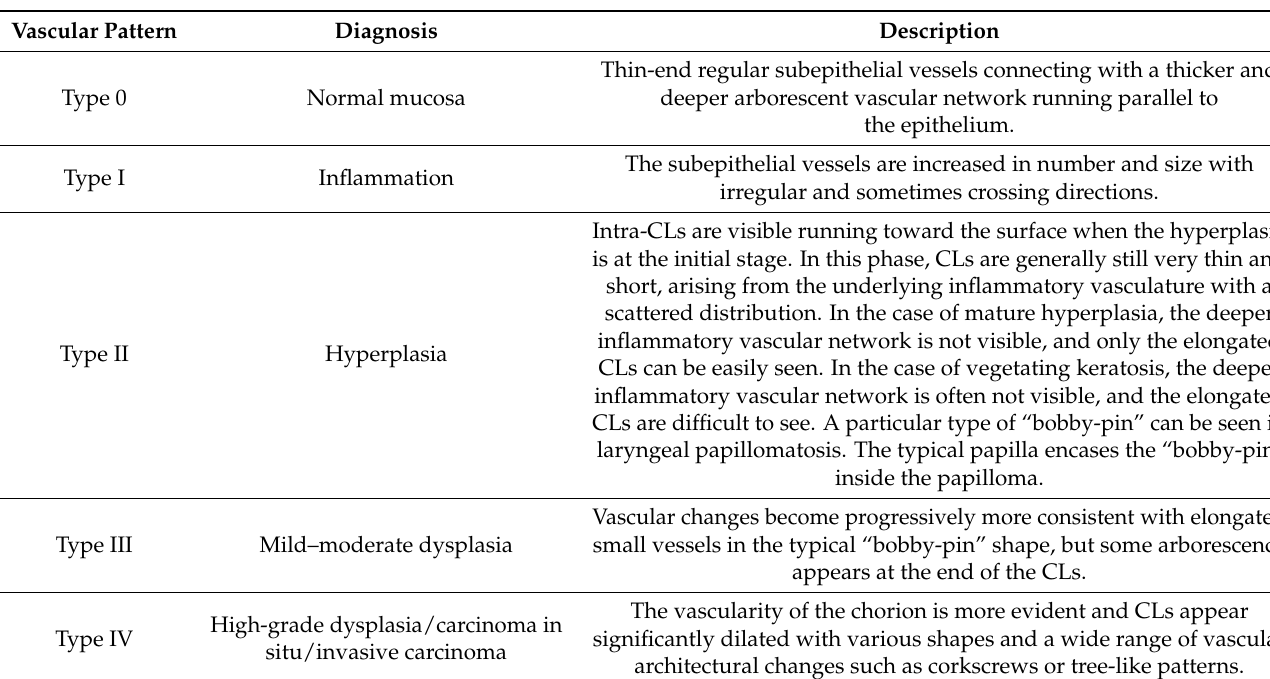
Table 3. Classification according to Puxxedu et al. (2016)